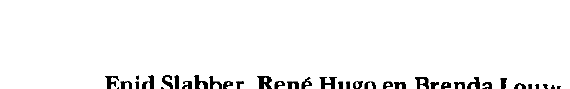
en dat die kind die reels van eenvoudige sinstrukture